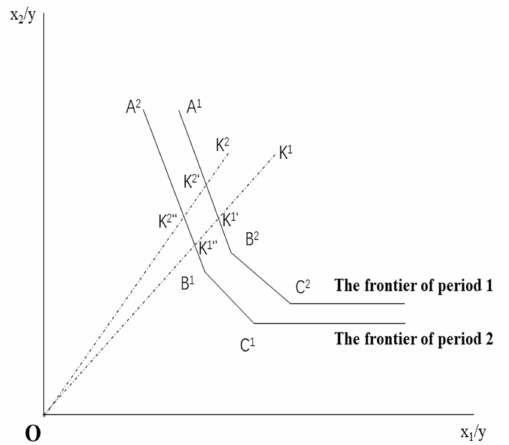
Figure 1. Diagram of Malmquist productivity